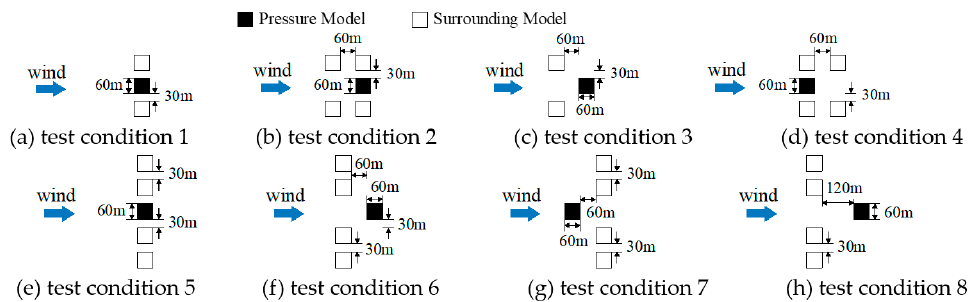
Figure 4. The layout of the real grouped tall buildings.